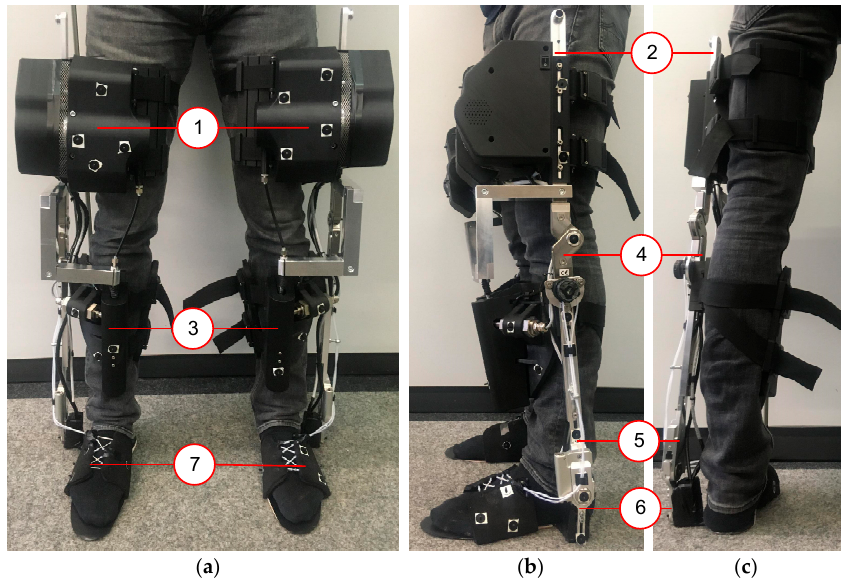
Figure 1. Novel exoskeleton robotic system to assist stair climbing called eBUS [4]: ( a ) attached to both legs in the frontal plane and ( b ) in the sagittal plane; ( c ) attached to the left leg in posterior view; (1) thigh segment, (2) thigh rail, (3) shank segment, (4) shank upper rail, (5) shank lower rail, (6) foot rail, and (7) foot segment.